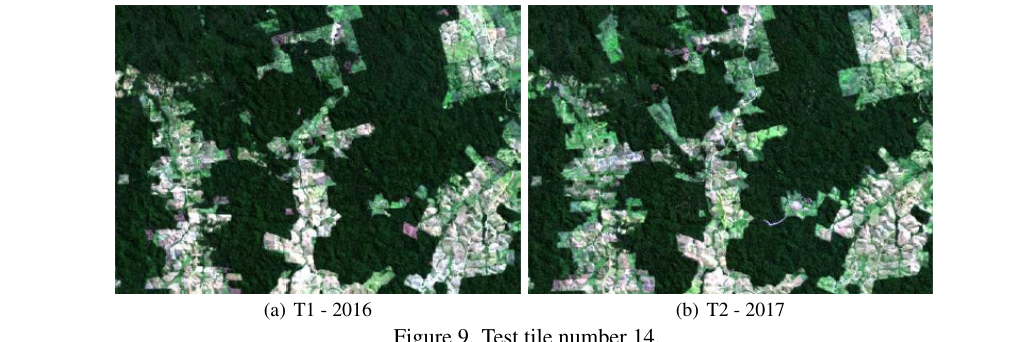
Figure 9. Test tile number 14.